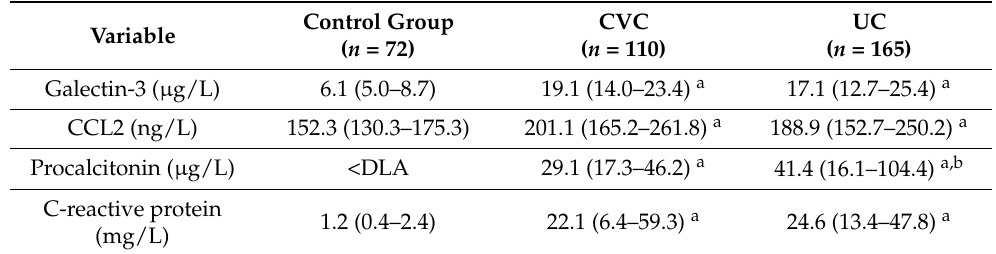
Table 2. Selected biochemical variables in the catheter-bearing patients and control group. Statistical analyses used the Mann–Whitney U test. Results are shown as the medians and